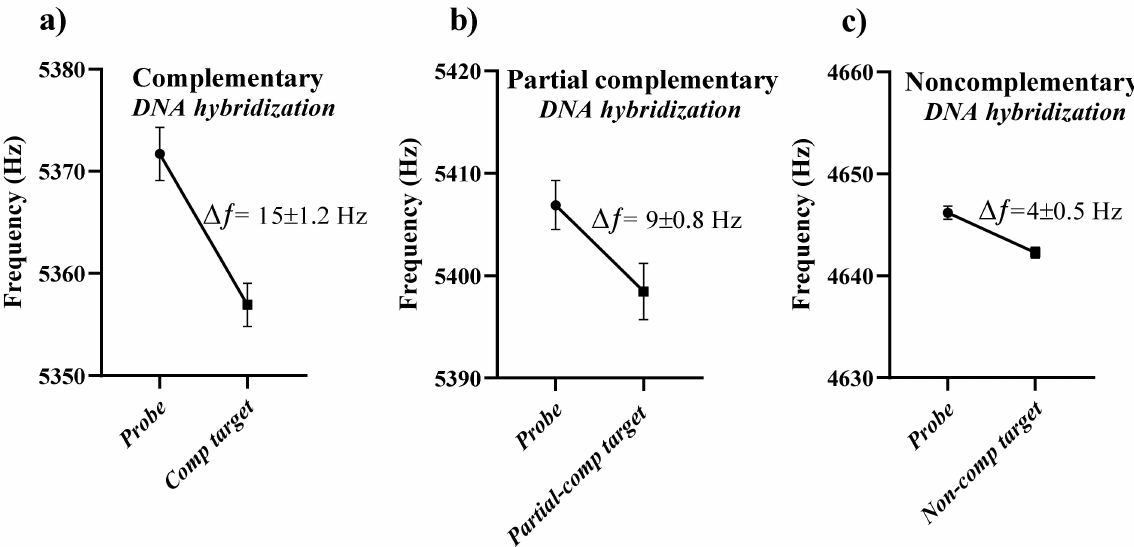
Figure 2. ( a ) The microcantilever’s resonance frequency shift after forming dsDNA by base-pairing of the probe and complementary ssDNA on the microcantilever surface. ( b ) The microcantilever’s resonance frequency shift after partial DNA hybridization of the probe and partial complementary target. ( c ) The resonance frequency shift in response to a mismatch of ssDNA of the probe and noncomplementary